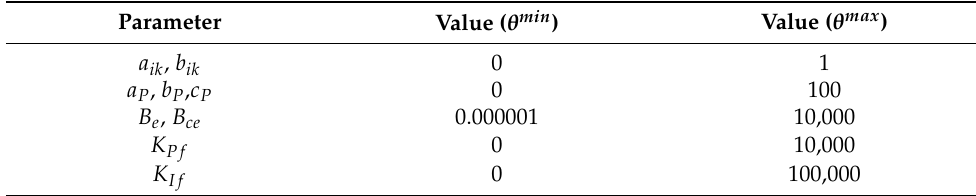
Table 2. Optimization search